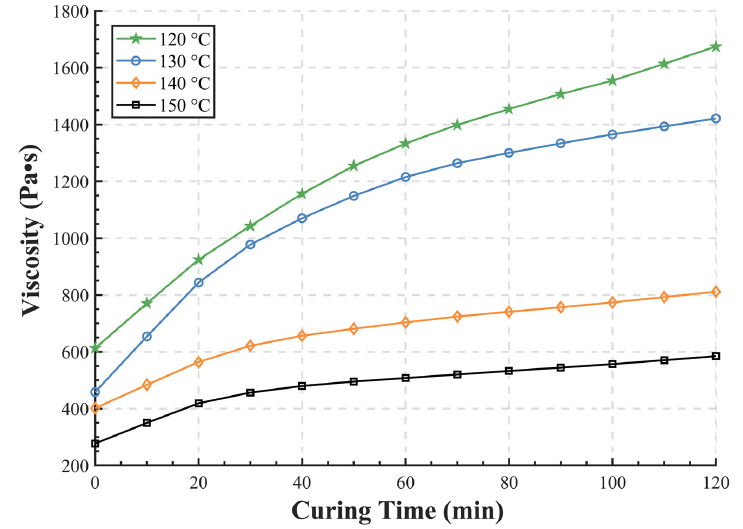
Figure 3. Viscosity test results of SBS-modified epoxy asphalt.